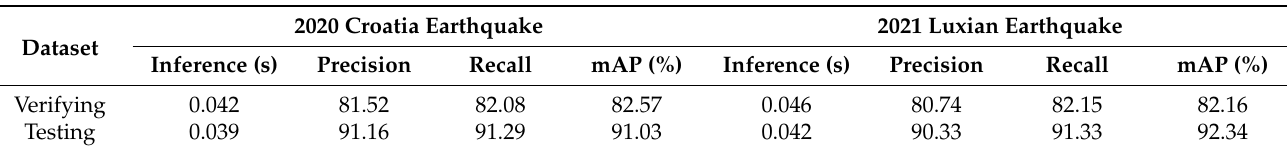
Figure 14. Damage recognition based on the verification dataset. ( a , b ) 2020 Croatia Earthquake; ( c , d ) 2021 Luxian Earthquake. Table 5. Validation results of building damage using different